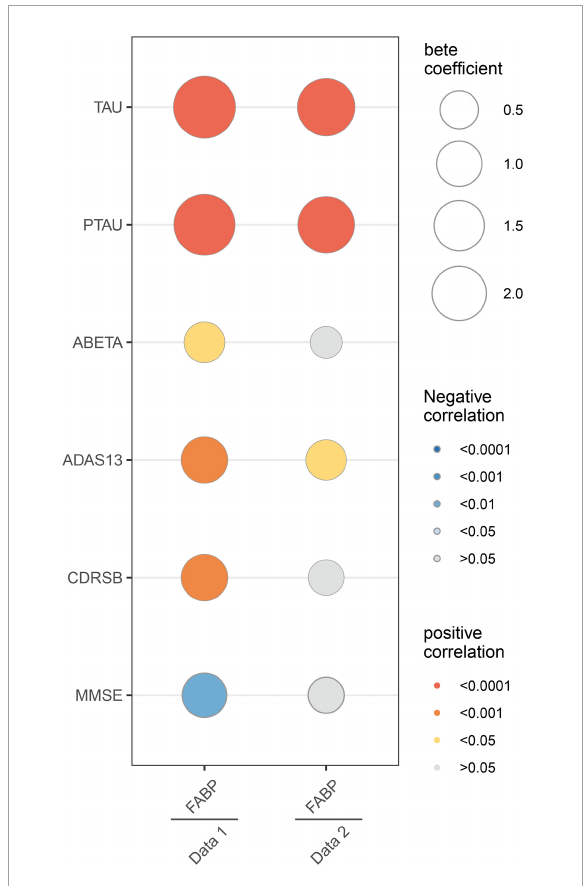
FIGURE1 Linear associations between fatty acid binding protein and Mini-Mental State Examination (MMSE), Clinical Dementia Rating sum of boxes (CDRSB), ADAS13, Amyloid beta (ABETA), TAU, and PTAU. The size of the bubble represents the correlation levels. The color of the bubble represents the beta coefficient levels. Red: positive correlation. Blue: negative correlation. MMSE, Mini-Mental State Examination; CDRSB, Clinical Dementia Rating sum of boxes; ADAS13, the cognitive section of Alzheimer’s Disease Assessment Scale; ABETA, Amyloid beta; P-tau, phosphorylated